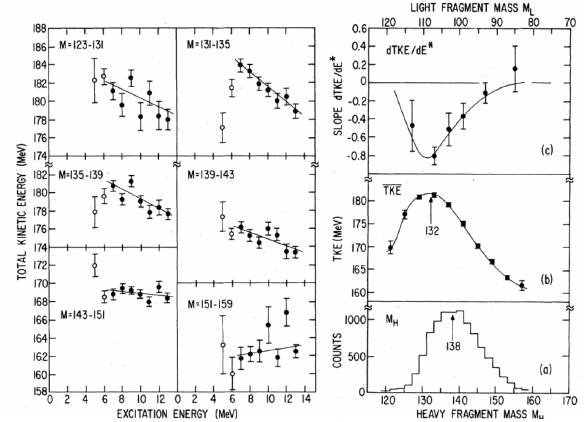
Figure 9. Left panel: The total kinetic energy of fission frag- ments from the 241 Pu( 3 He, ↵ f) reaction is plotted for di ↵ erent heavy fragment mass bins. Solid lines represent best fits to the data over the E X = 7-13MeV range. Right panel: The heavy frag- ment mass distribution (a), the total kinetic energy (b) and the TKE slope with excitation energy (c) are plotted as a function of the 240 Pu excitation energy. Figure taken from Ref. [21].